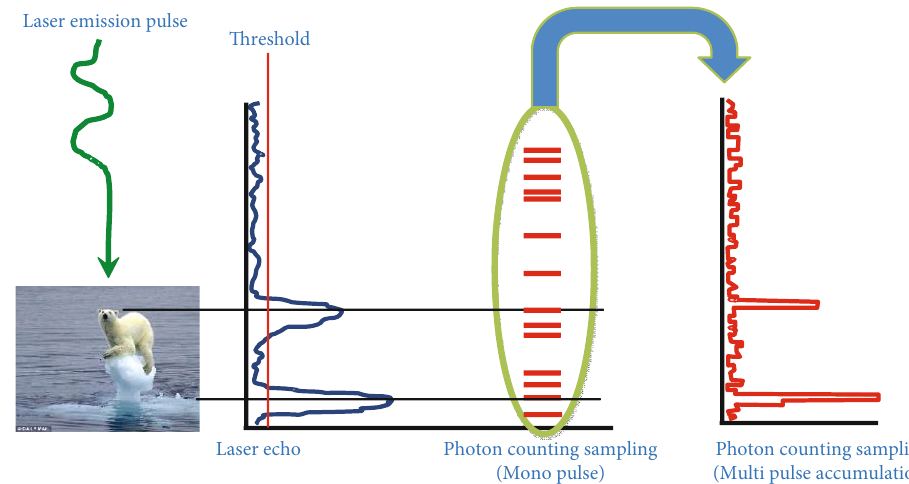
Figure 1: Operation schematic diagram for single-photon laser detection.